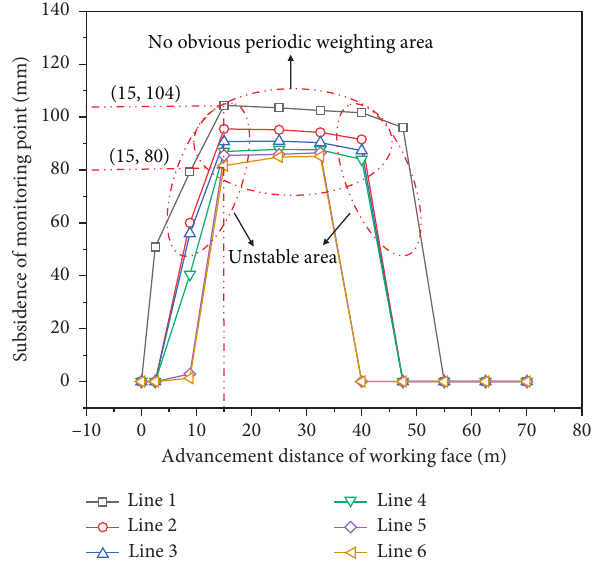
Figure 13: Subsidence of monitoring